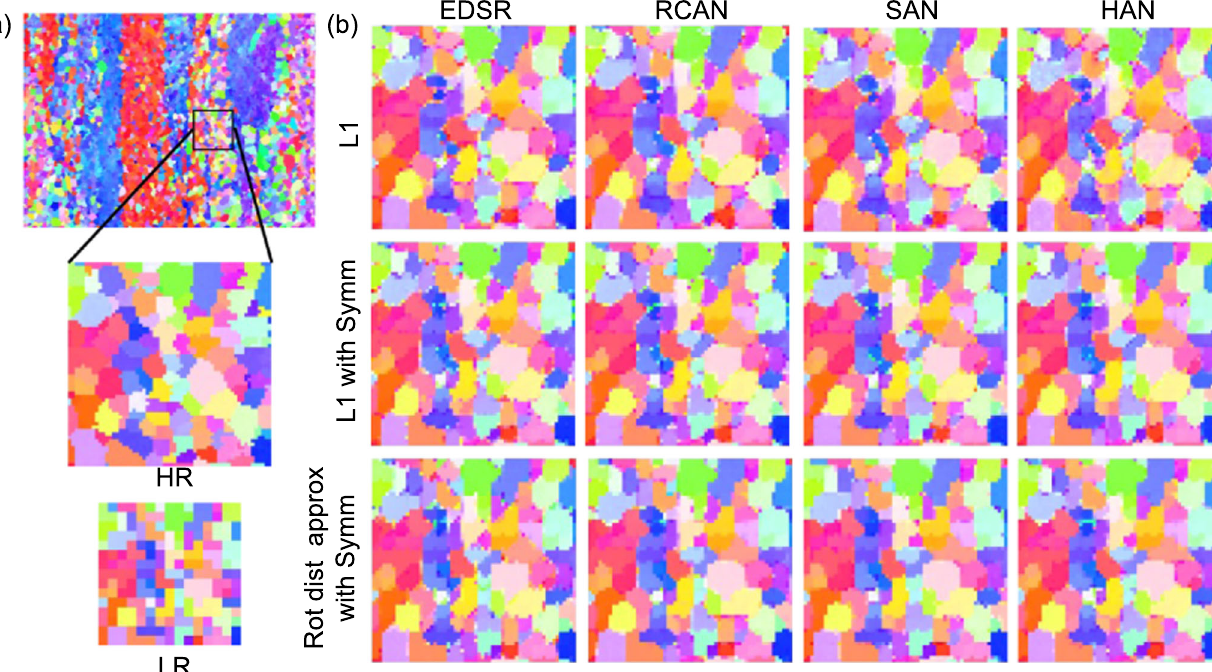
Fig. 5 Visual Comparison of 4x EBSD-SR on a test EBSD map. L 1 has non-physical structure at grain boundaries, and L 1 with symmetry and approximate rotational with symmetry reduce the non-physical structures at grain boundaries. a The comparison of LR and HR for a single patch of size 64 x 64 in an EBSD map. b Compares super-resolved EBSD maps for the same patch across different architectures and